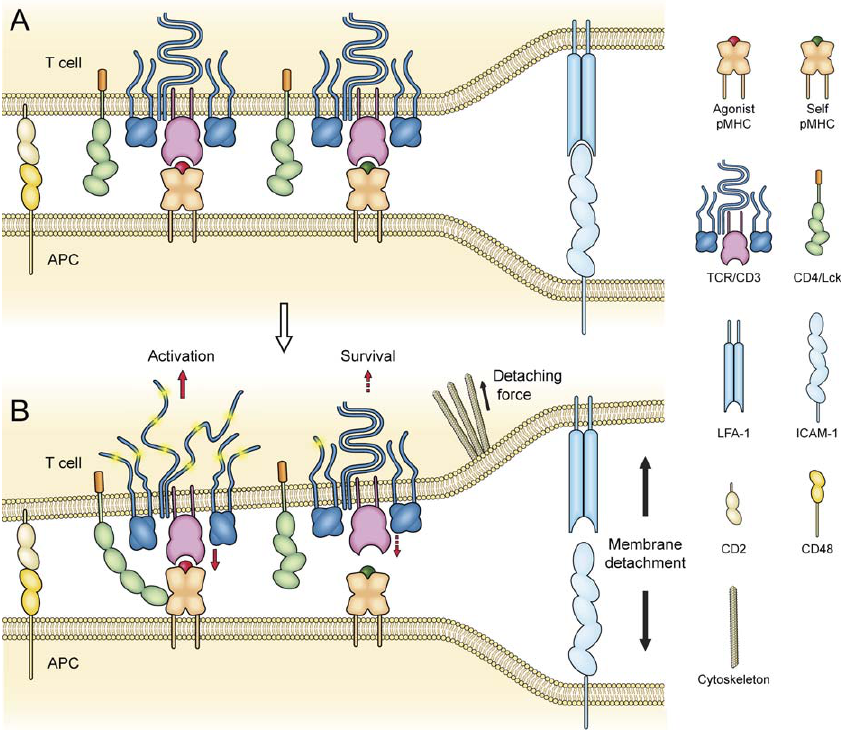
Figure 7. The Receptor Deformation Model of TCR Triggering (A) Interaction of pMHC and TCRs at the membrane–membrane contact site of the T cell/APC interface facilitated by adhesion molecules. The interaction between agonist pMHC and TCR per se does not initiate TCR signaling. (B) Forces generated from the cytoskeleton, which drive T cell morphological changes and active T cell movement relative to the APC, detach the T cell plasma membrane from the APC. Part of this force is delivered to the TCR/CD3 complex via pMHC-TCR binding. Binding between agonist pMHC and TCR is strong enough to deliver a force that deforms the TCR/CD3 complex to a conformation capable of initiating an activation signal. Weak binding between TCR and self pMHC breaks before such a force can be delivered. This binding could, however, deliver a weak force that causes minor receptor deformation, leading to a survival signal. The detaching force might also deform the MHC molecule to a conformation that binds coreceptors with higher